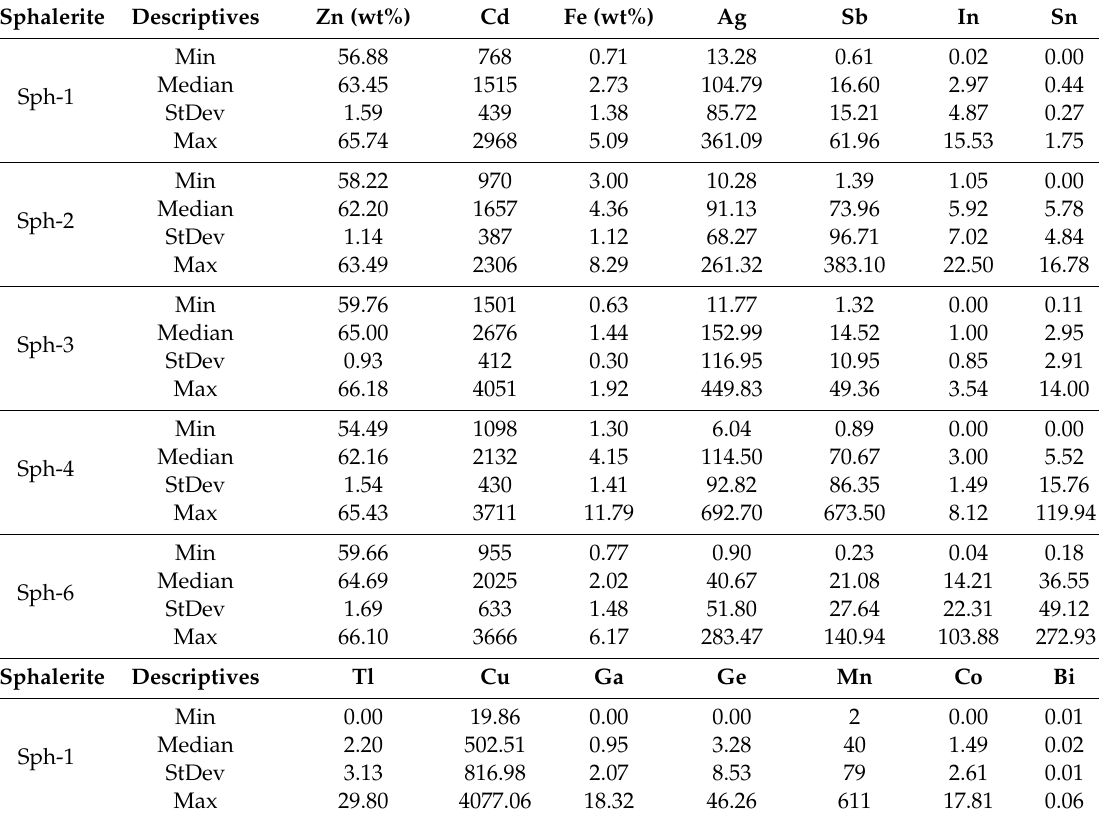
Table 1. The minimum, median, standard deviation and maximum values for the trace elements in sphalerite analysed in this study. All values are in ppm unless otherwise